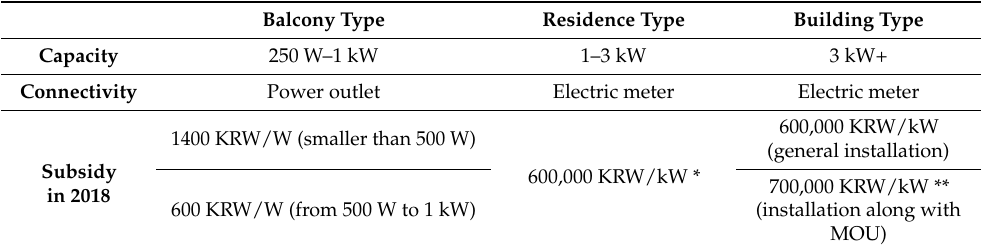
Table 2. Classification of mini-PV and municipal installation subsidy